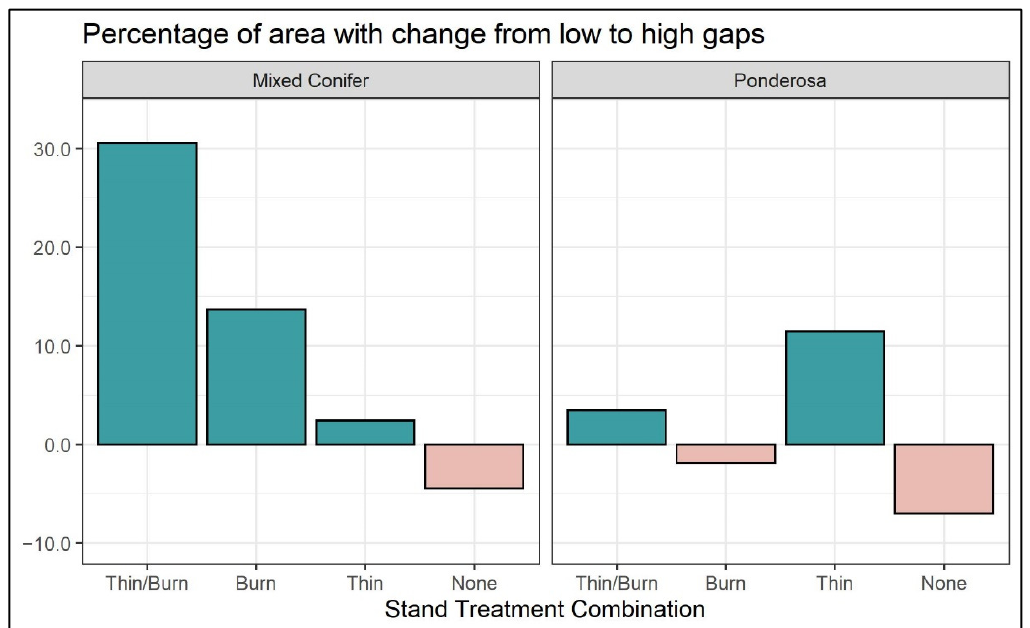
Figure 7. Percentage of area with predicted change from low gaps to high gaps in each sample unit following hazard fuel reduction; ponderosa pine and dry mixed-conifer forest types on the Malheur National Forest near John Day, OR, USA. A positive change indicates an increase in high gaps, and a negative change indicates a decrease in high gaps.